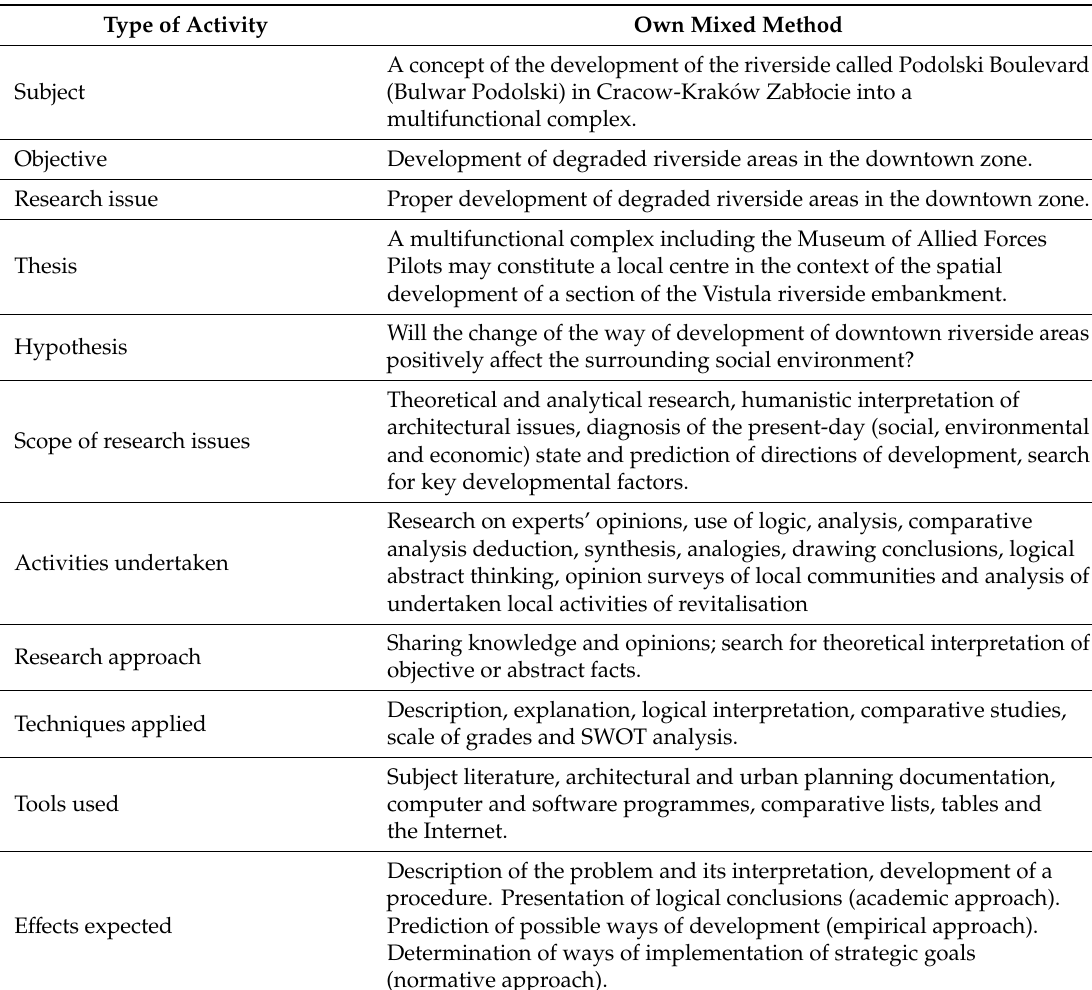
Table 1. Development of own mixed method on the basis of heuristic methods and the method of logical argumentation, (table by E. Latusek, based on